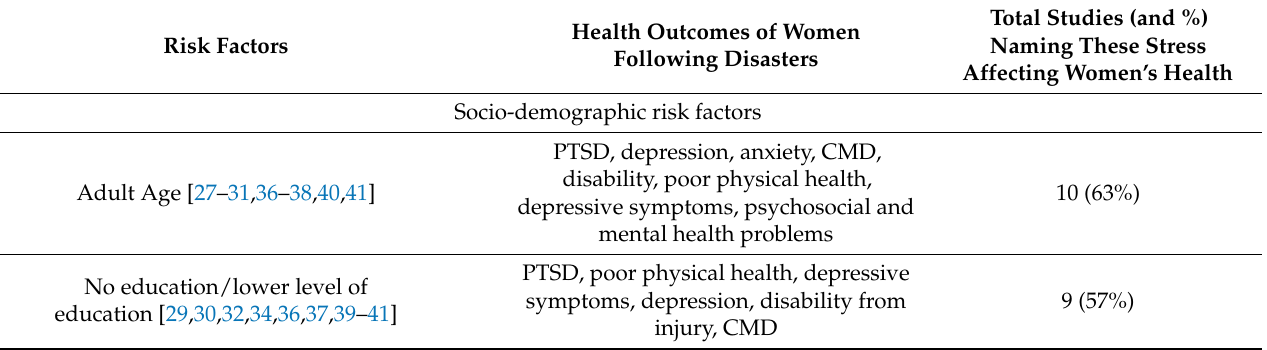
Table 3. Risk factors and health outcomes of women of selected